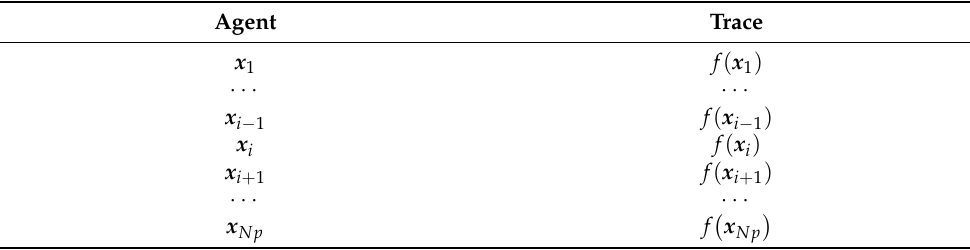
Table 2. Population and fitness arrangement in